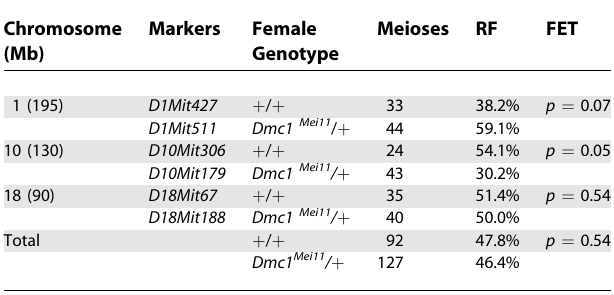
Table 1. Recombination Rates in Offspring of Wt and Dmc1 Mei11 / þ Females Chromosome (Mb)